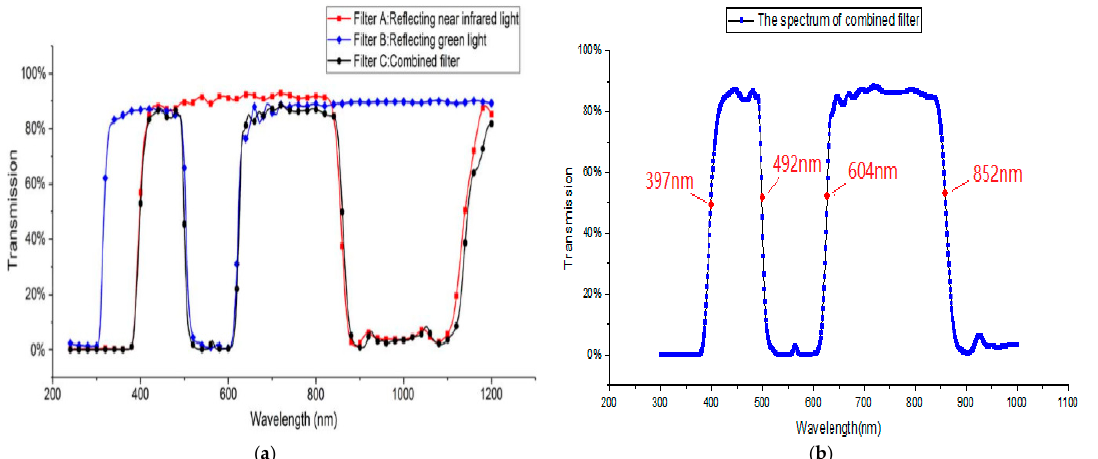
Figure 1. The splitting sunlight technology used polymer multilayer films to separate sunlight ( a ) The spectrum of the individual polymer films and ( b ) the spectrum of the combined polymer films.